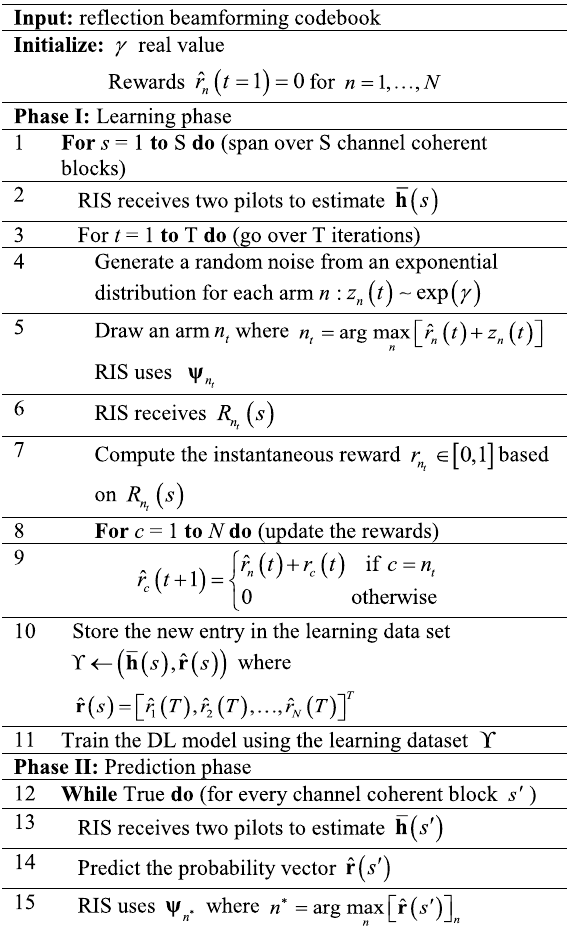
Table 2 Follow the perturbed leader (FPL) scheme for reflection beamforming